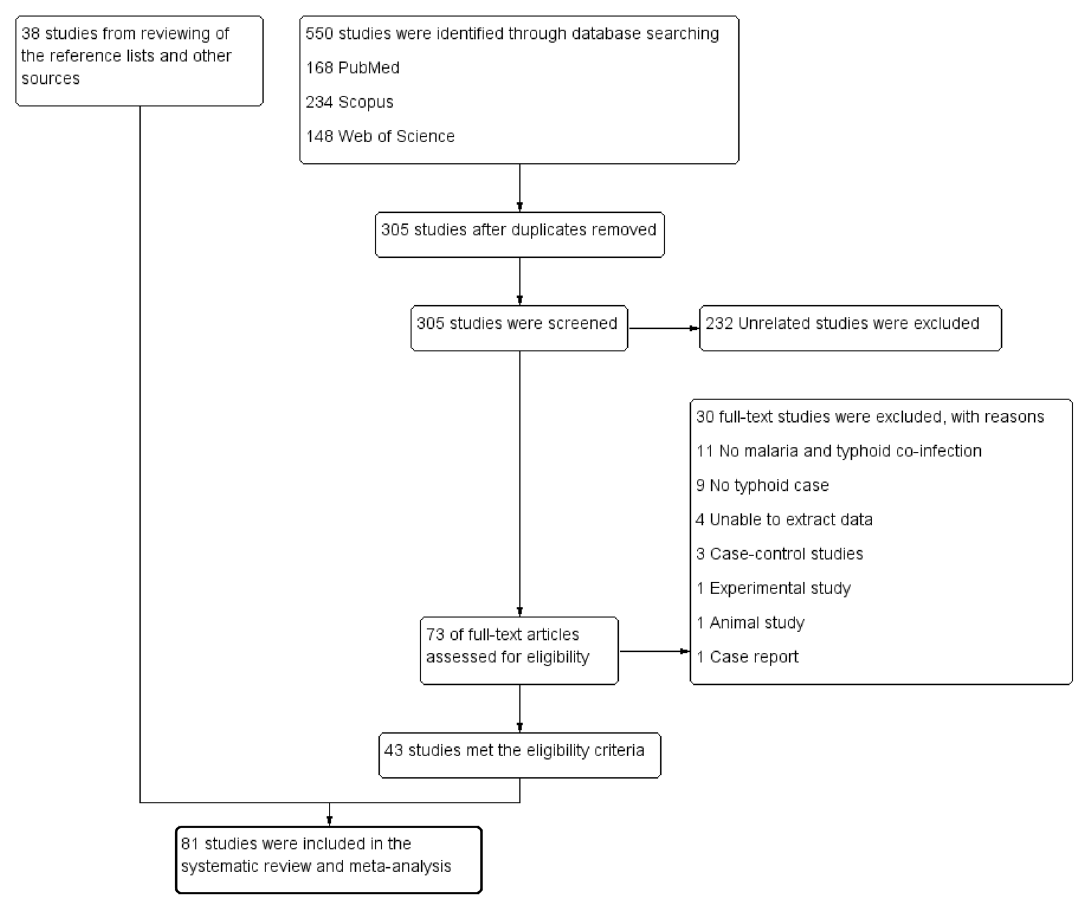
Figure 1. Study flow